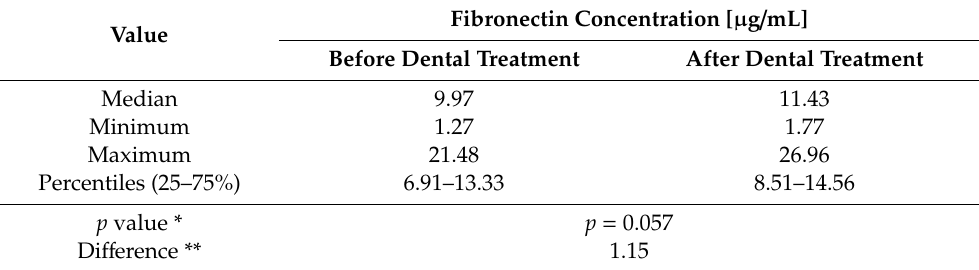
Table 1. The statistical parameters of MMP-1 and MMP-2 concentrations in saliva before and after dental treatment. MMP-1 MMP-2 Concentration (ng / mL) Concentration (ng / mL) Value Before Dental After Dental Before Dental After Dental Treatment Treatment Treatment Treatment Median 12.27 13.48 438.62 204.70 Minimum 2.45 0.90 96.72 97.04 Maximum 21.78